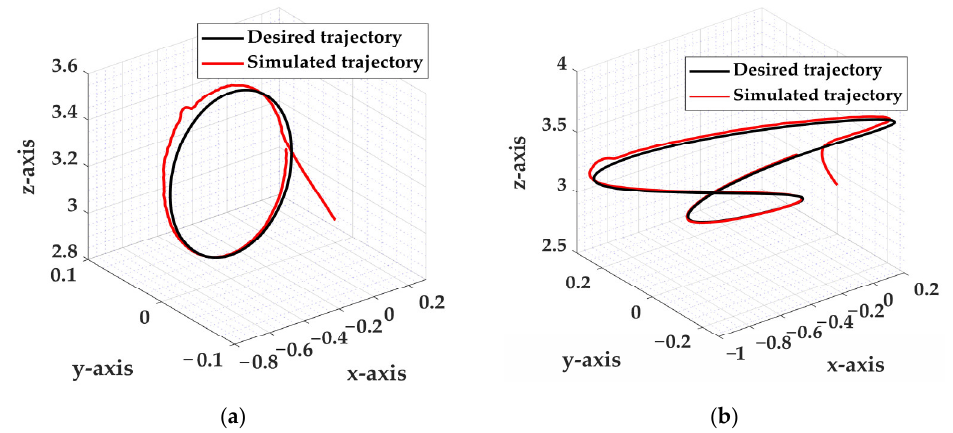
Figure 13. ( a ) Trajectory tracking without wave excitation; ( b ) Trajectory tracking with wave excitation.